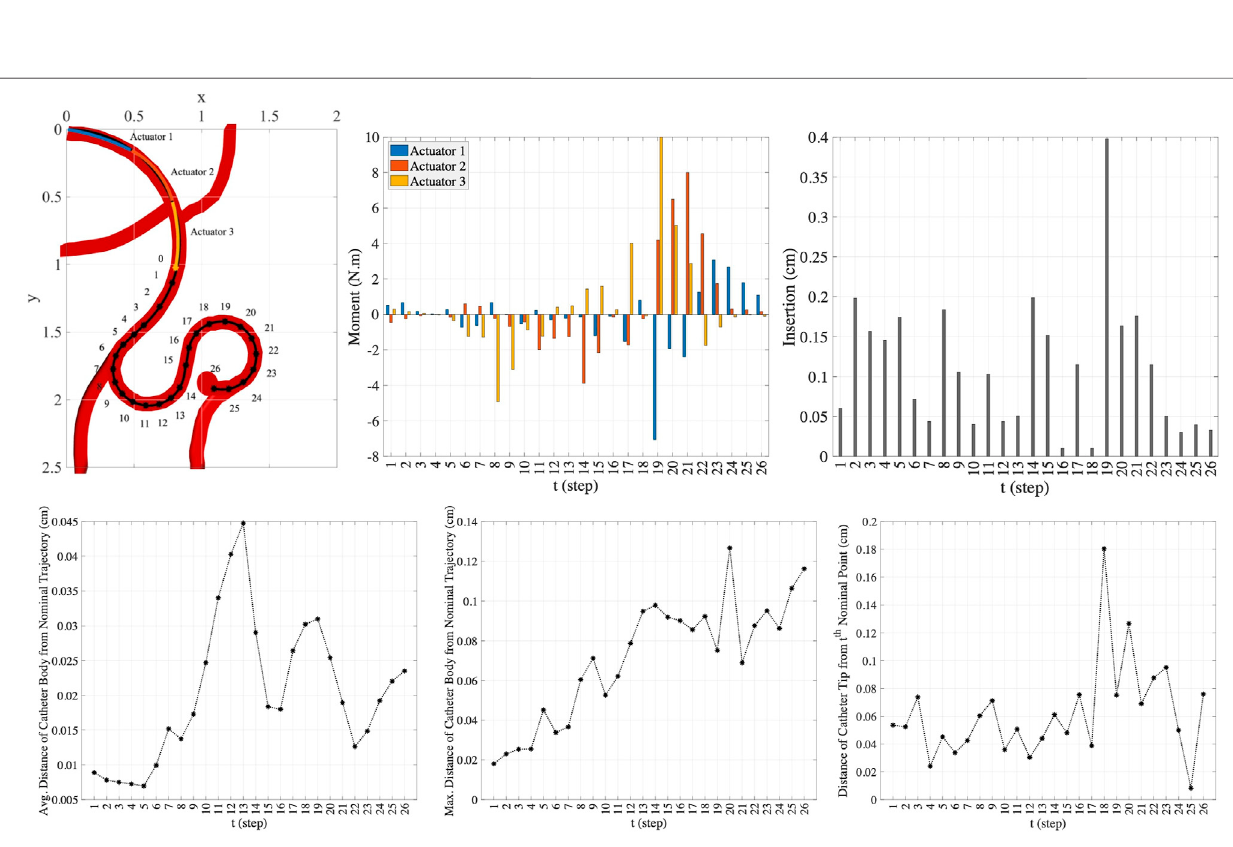
Frontiers in Robotics and AI |